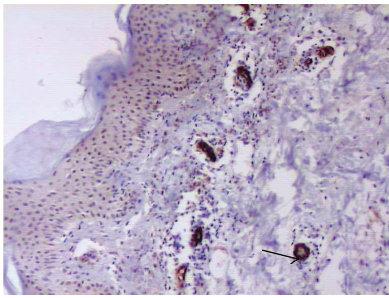
Figure 5: Healthy skin, immunohistochemistry. Signal for β 4 inte- grin in single basal keratinocyte (original magnification x100).